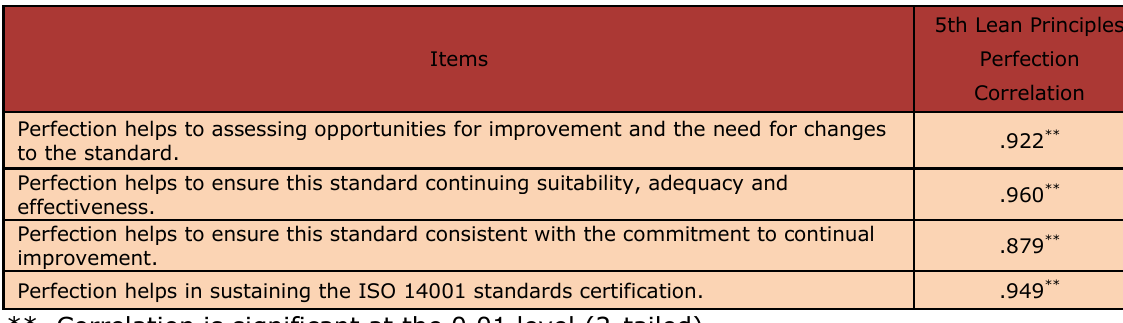
Table 10. Perfection with ISO 14001